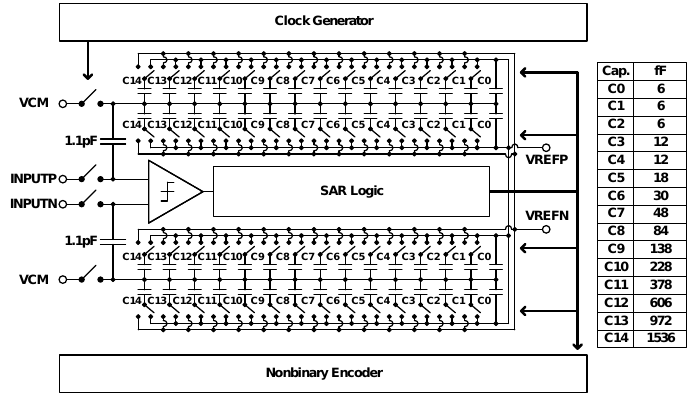
Figure 8. Circuit schematic of the analog-to-digital